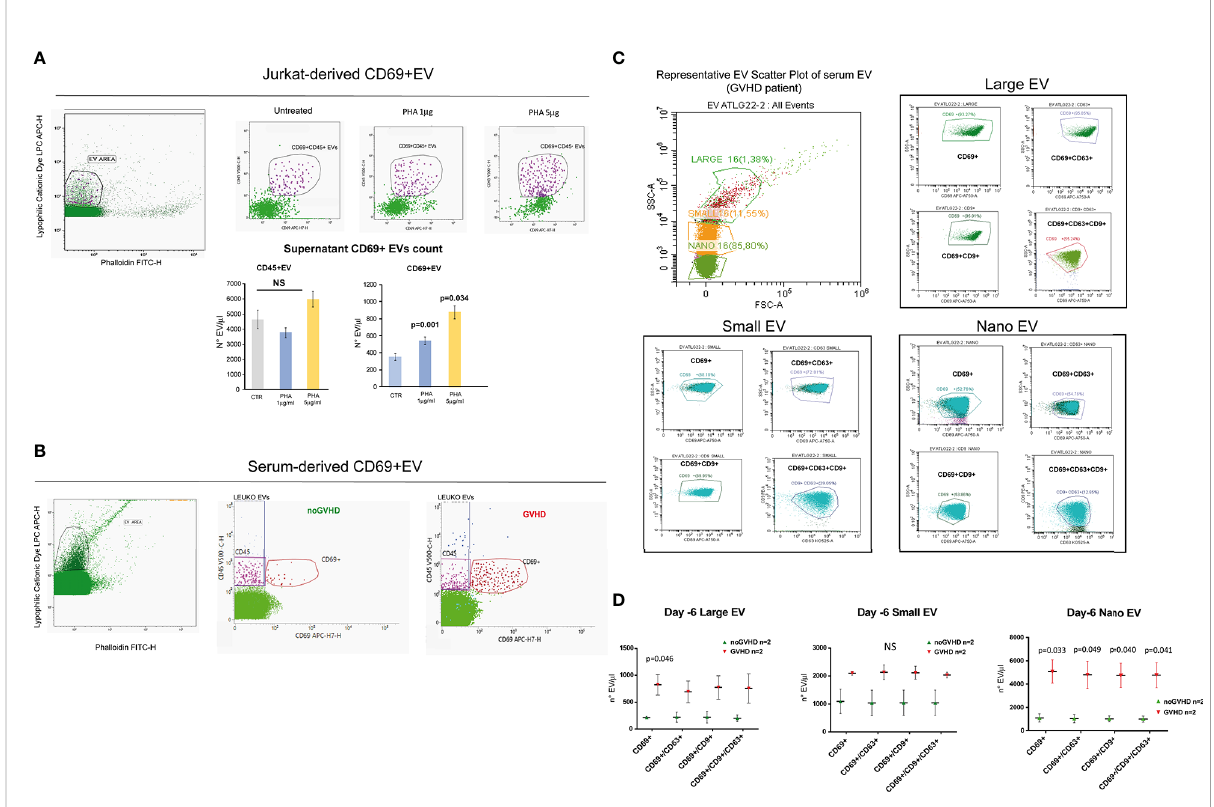
FIGURE 4 Phenotypic characteristics of CD69+ EVs in HSCT samples. (A) Representative gating strategy for EV detection from un-stimulated CD69+ Jurkat T cells and upon stimulation with PHA (1 or 5 m g/ml) for 72 h. Bar graphs represent the concentration of CD69+ EVs and CD45+ EVs in the culture supernatants. (B) Representative gating strategy for EV detection in the serum of HSCT patients. (C) Cyto fl ex analysis of serum EV in a representative GVHD patient. Plots refer to the concentration of CD69+, CD69+CD63+, CD69+CD9+, CD63+CD9+CD63+ among large (900 µm), small (160 – 500 nm), and nano (100 nm) EV fraction (see Supplementary Figure 1). (D) , Graphs charts of serum CD69+, CD69+CD63+, CD69+CD9+, CD63+CD9+CD63+ EVs according to size distribution in GVHD (n = 2) and noGVHD patients (n = 2). Values are expressed as number of EV/ m l. Data are represented as mean +/- S.D. NS, Not Signi fi